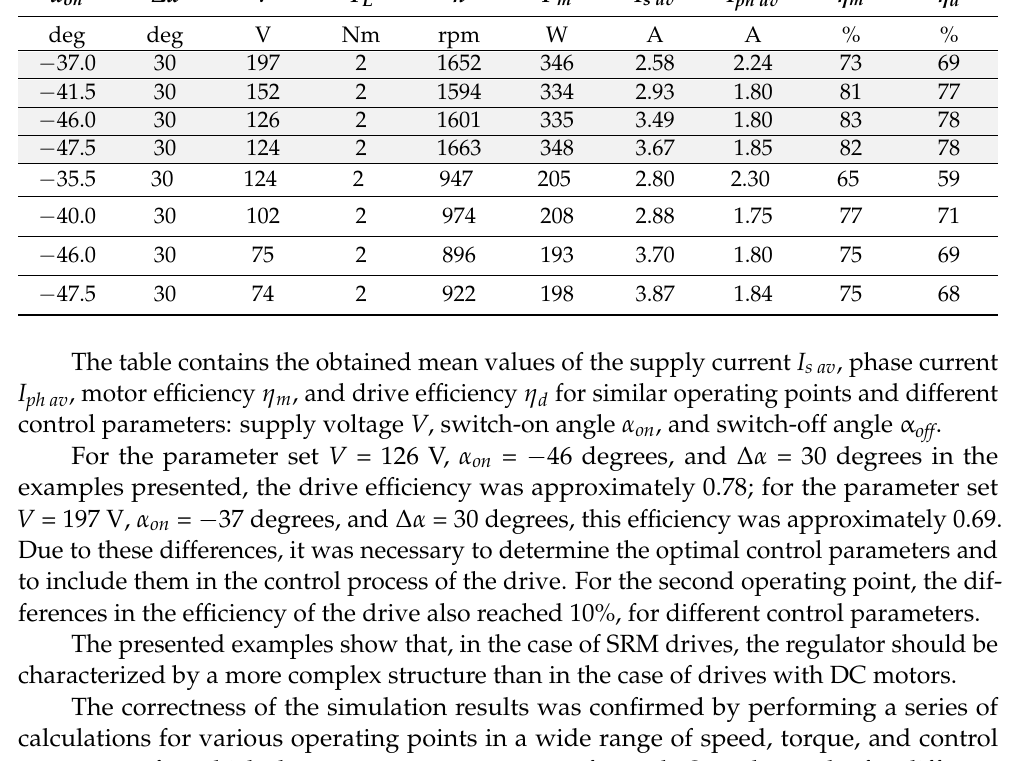
Table 2. Two examples of measurement results of the drive parameters obtained for similar operating points at different values of the control